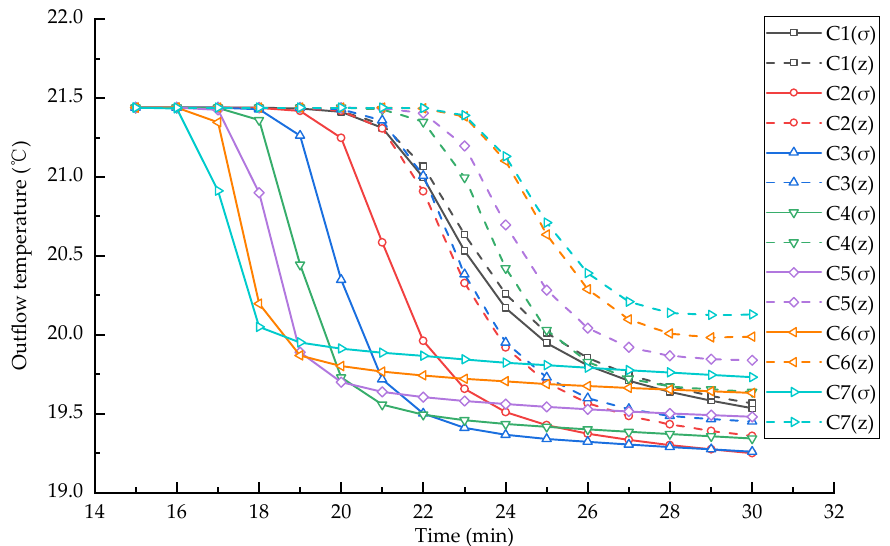
Figure 8. Comparison of outlet water temperature of the σ -coordinate system and the z-coordinate system models under different bottom slopes conditions.